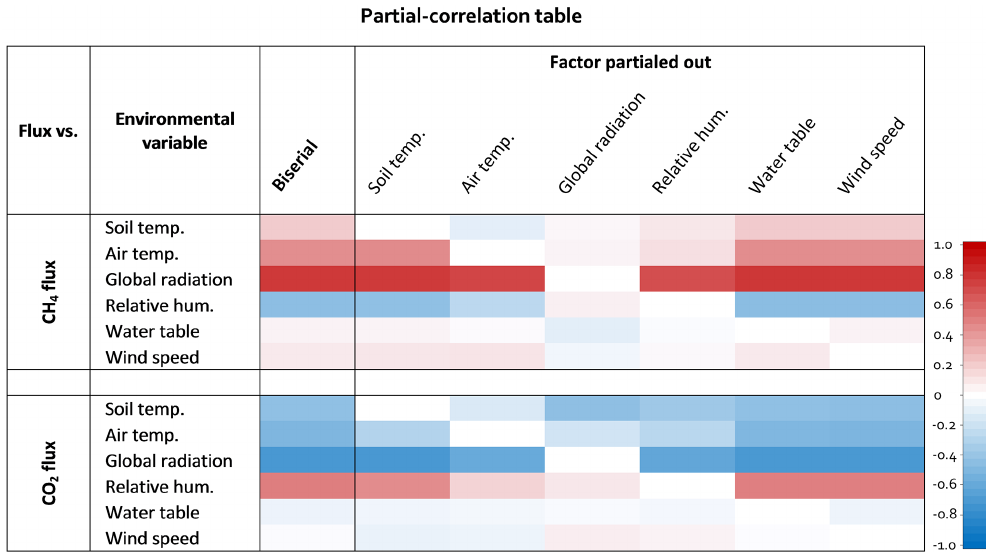
Figure 5. Biserial and partial correlations between CH 4 flux (above) or CO 2 flux (below) and environmental variables within the growing season (May–October). Each variable (soil temperature, air temperature, global radiation, relative humidity, water table height and wind speed) is partialed out and the corresponding correlations with the other variables are shown in the same column. The darker the cells the higher the correlation coefficient, with the red colors for positive correlations and blue colors for negative correlations.